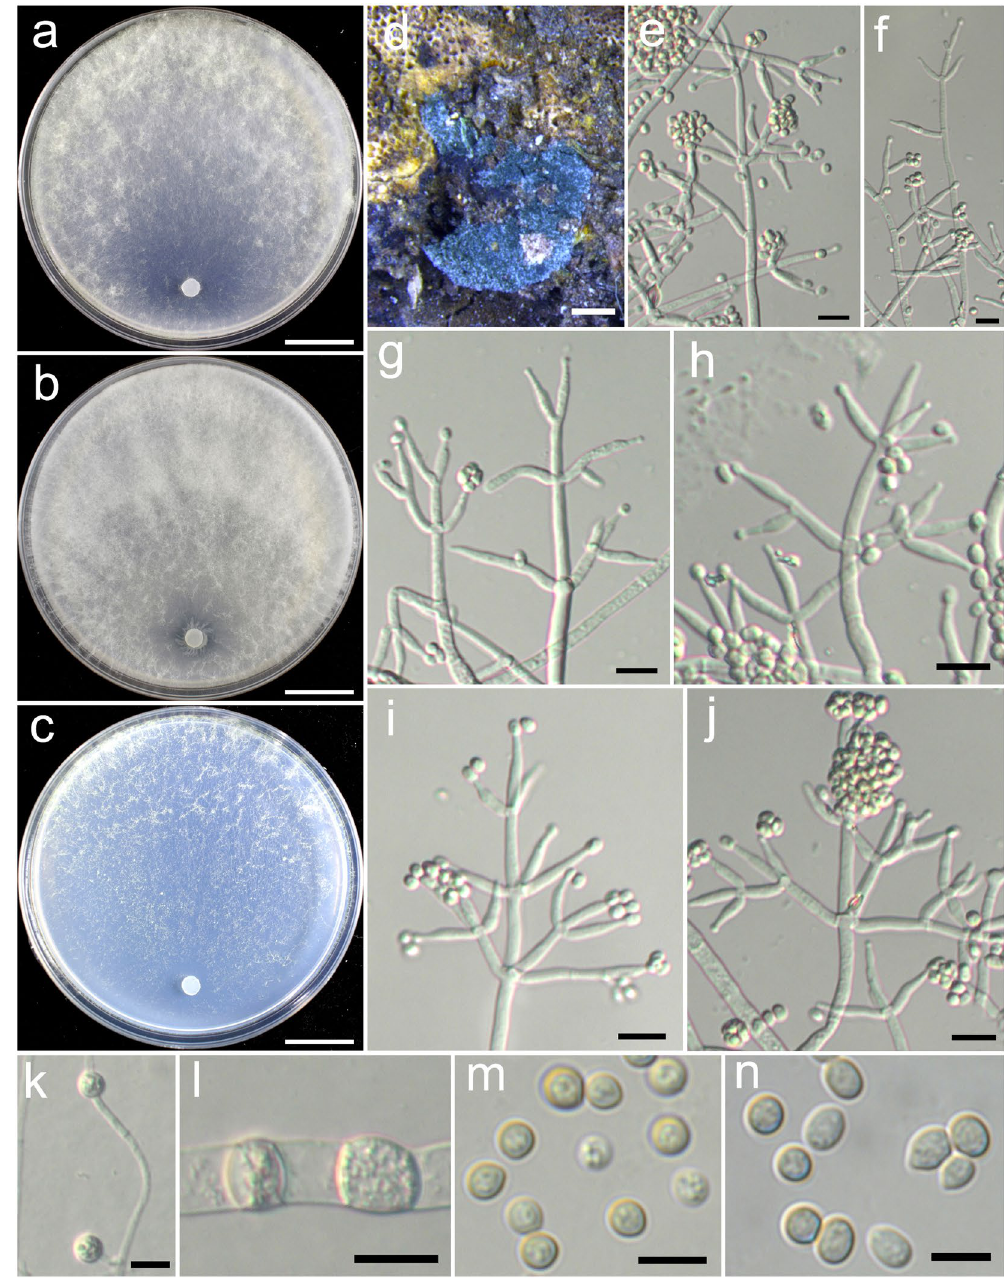
Figure 19. Trichoderma polypori (HMAS 248855). ( a – c ) Cultures at 25 °C, 7 d (a. on CMD, 10 d; b. on PDA, 7 d; c. on SNA, 7 d); ( d ) Conidial pustules on polypore; ( e – j ) Conidiophores and phialides (SNA, 6 d); ( k , l ) Chlamydospores (SNA, 6 d); ( m , n ) Conidia (SNA, 6 d). Bars: a–c = 20 mm. d = 400 μ m. e–l = 10 μ m. m–n = 5 μ